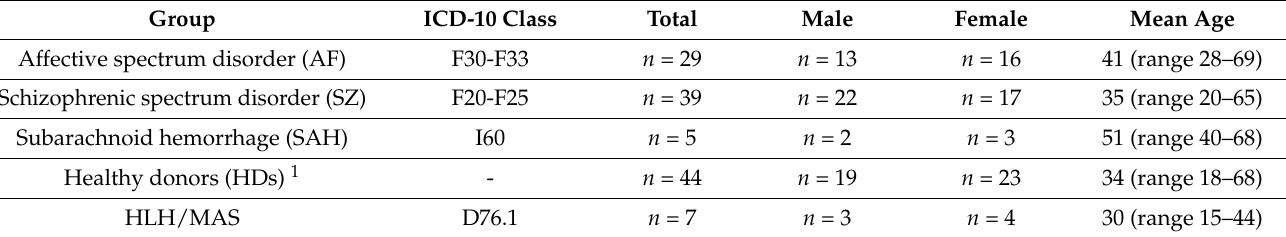
Table 2. Cohort characteristics of patients and controls.